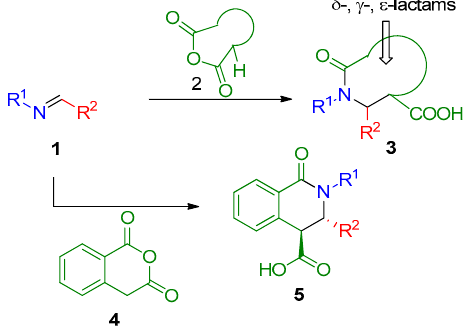
Figure 1. The Castagnoli–Cushman reaction (CCR).